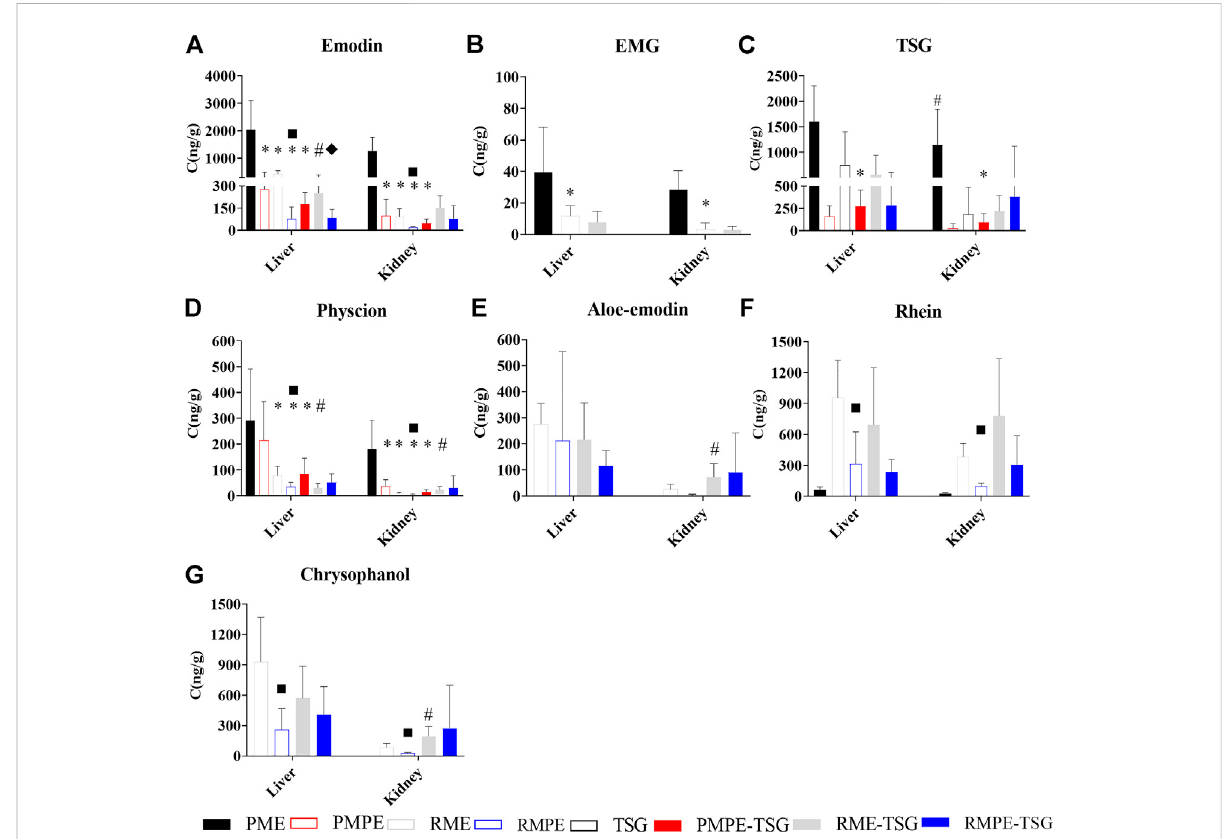
FIGURE 5 The contents of seven key components in mice liver and kidney tissues of each experimental group for the PM hepatotoxicity study. Data were expressed as mean ± SD ( n = 6); Two-tailed independent Student ’ s t -test was conducted between two experimental groups. When p < 0.05, there was a statistical signi fi cance. *: p < 0.05, PMPE, RME, RMPE or PMPE-TSG group versus PME group; #, p < 0.05, PME or each combination group versus correspondingherbalextract-onlygrouporTSGgroup; ■ , p < 0.05,RMPEgroup versus RMEgroup; ◆ , p < 0.05,RMPE-TSGgroup versus RME-TSG group. (A) emodin; (B) EMG; (C) TSG; (D) Physcion; (E) Aloe-emodin; (F) Rhein; (G)